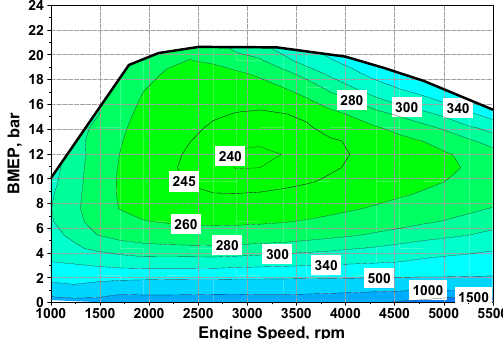
Figure 4. Thermal engine 2 BSFC map (g/kWh).